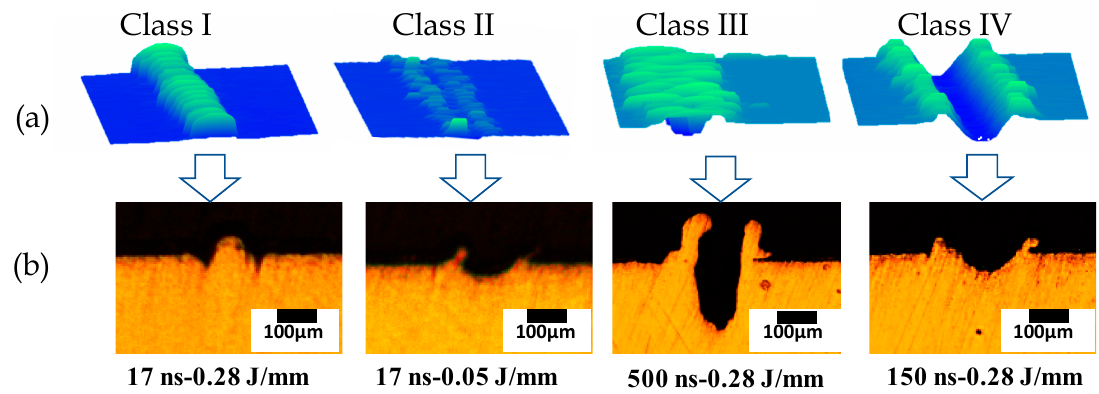
Figure 5. ( a ) 3D profiles of various classes of groove produced during the single-line machining and the ( b ) corresponding cross-sectional